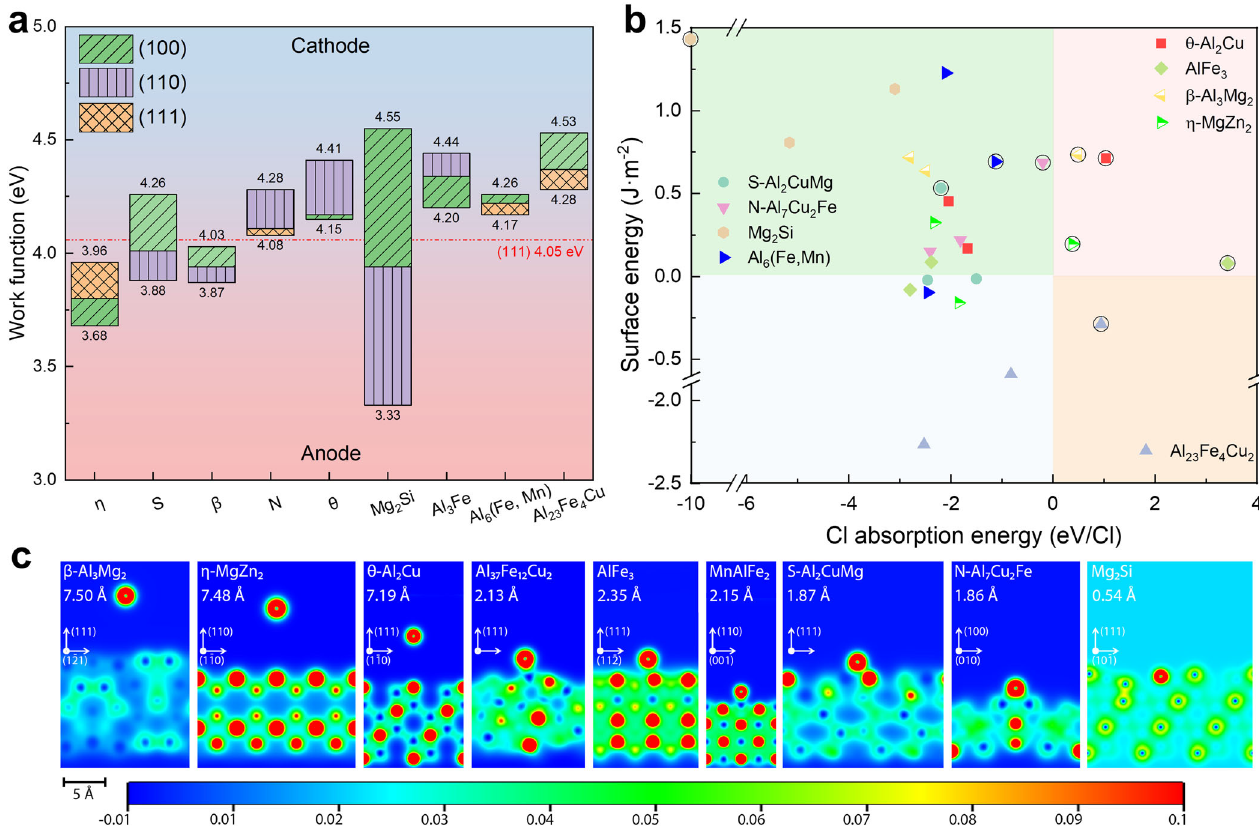
Fig. 6 Ab-initio calculations for the Al alloys secondary phases. a WF. Three orientations, (100), (110), and (111), were considered. The lowest WF is depicted as a line, and the remaining two surfaces are expressed in the form of summation on this line. b The phase surface energies and their adsorption energies for the Cl atom. The surface with the lowest WF of each phase is surrounded by a black circle. c Adsorption distance and charge distribution between the Cl atom and the phase surface with the lowest